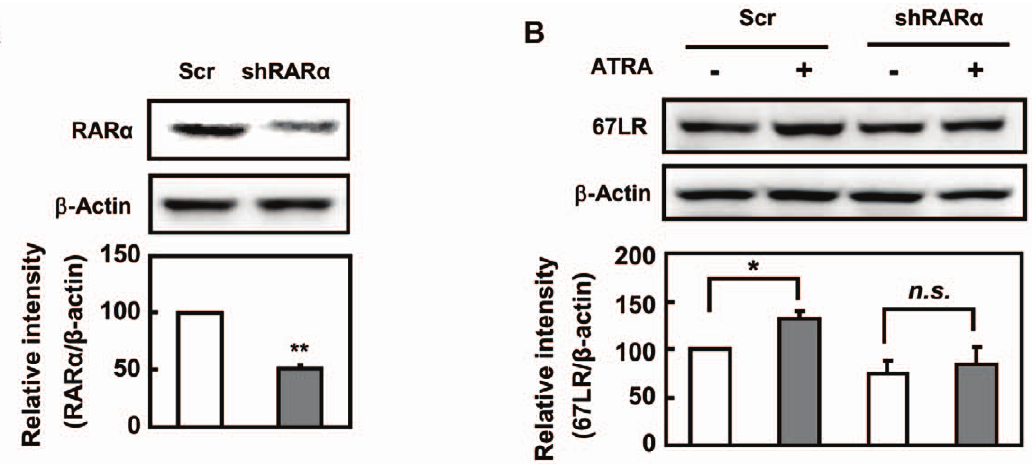
Figure 4. ATRA enhances the 67LR expression via RAR a . A ) RAR a knockdown in B16 cells stably transfected with RAR a shRNA expression vector was confirmed by Western blot analysis. B ) B16 cells stably transfected with the control shRNA or the RAR a shRNA expression vector were treated with or without 0.1 m M ATRA in DMEM supplemented with 1% FCS for 48 h. Levels of 67LR expression were analyzed by Western blot analysis and were normalized to b -Actin. Band intensities were quantified using NIH Image J software.